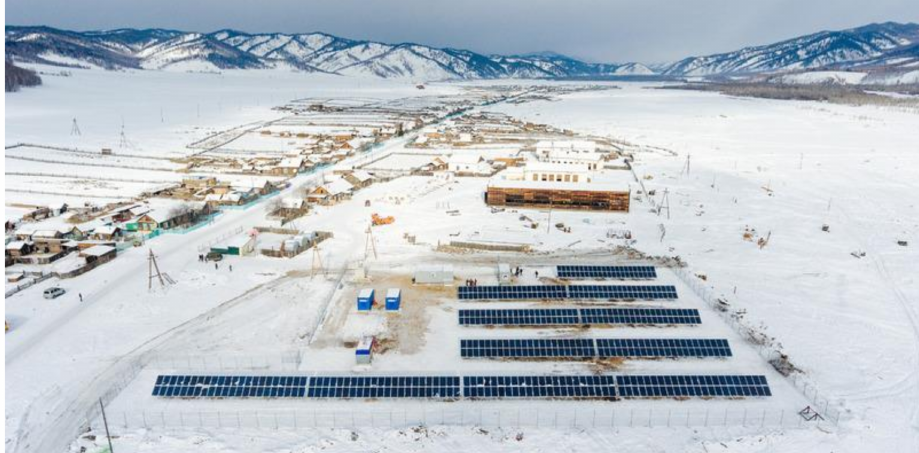
Figure 1. Application of solar collectors in the oil and gas field in subarctic conditions.